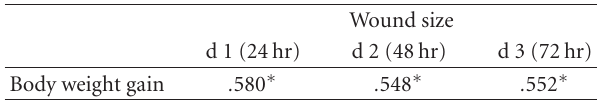
Table 3: Relationships (Pearson’s correlation coe ffi cients) between body weight gain and wound size.